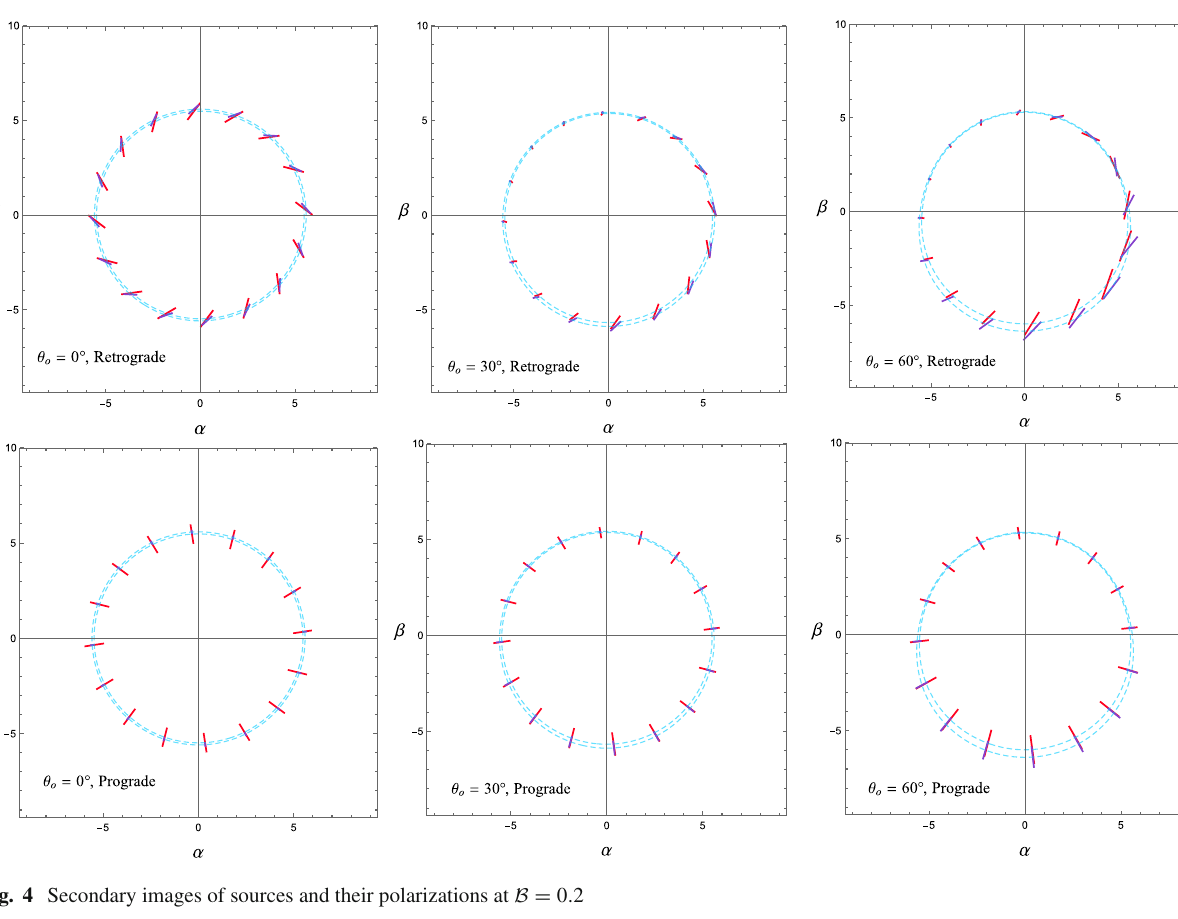
Fig. 4 Secondary images of sources and their polarizations at B = 0 . 2